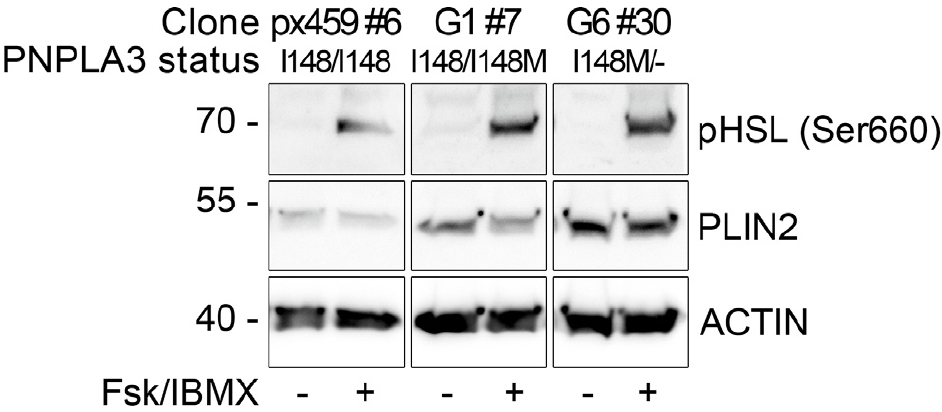
Figure A8. Induction of lipolysis in CRISPR/Cas single cell clones. Immunoblot analysis of phospho- HSL and perilipin 2 in CRISPR/Cas single cell clones after 1 h induction of lipolysis with 10 µM forskolin and 500 µM IBMX. Induction of lipolysis was indicated by a substantial increase in phosphorylated HSL (Ser600, pHSL) in all clones analyzed. Note that unmodified cells of origin (px459 #6) negative on both alleles for PNPLA3(I148M), showed the lowest expression for perilipin 2 (PLIN2), whereas higher levels were observed in the PNPLA3(I148M) heterozygous clone (G1 #7), and the highest PLIN2 levels in the clone carrying the PNPLA3(I148M) missense variant on one allele and on the other a knockout for PNPLA3. Molecular weight (kDa) is given on the left.